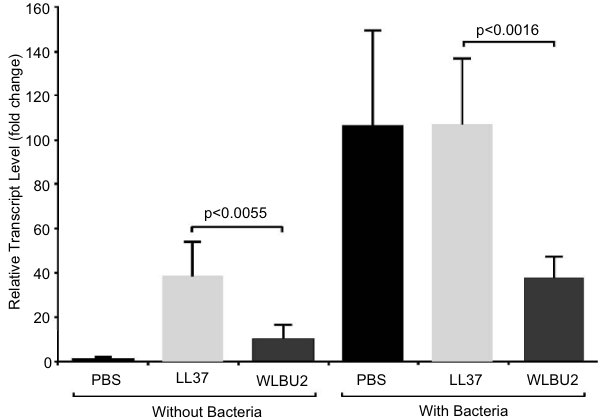
Figure 4. Intraperitoneal WLBU-2 suppresses IL-1 β in lungs systemically exposed to P. aeruginosa (PA). Wild-type C57BL/6 animals (n=5/group) received intraperitoneal injections of PBS or PA (1×10 6 cfu/mL), followed by intraperitoneal injections after 2h of PBS (black bars) , LL-37 (4mg/kg, light grey bars ), or WLBU-2 (4mg/kg, dark grey bars ), with subsequent measurement by quantitative RT-PCR of IL-1 β transcripts ( y axis, fold change in relative transcript level) from lung tissue harvested 24h post exposure. Data represent